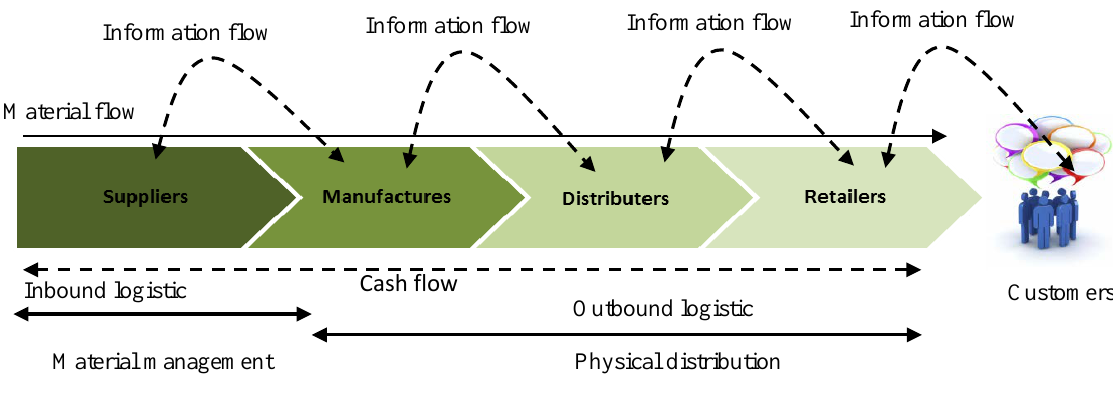
Fig. 1. Stage of SCM (figure modified from Chopra & Meindl,